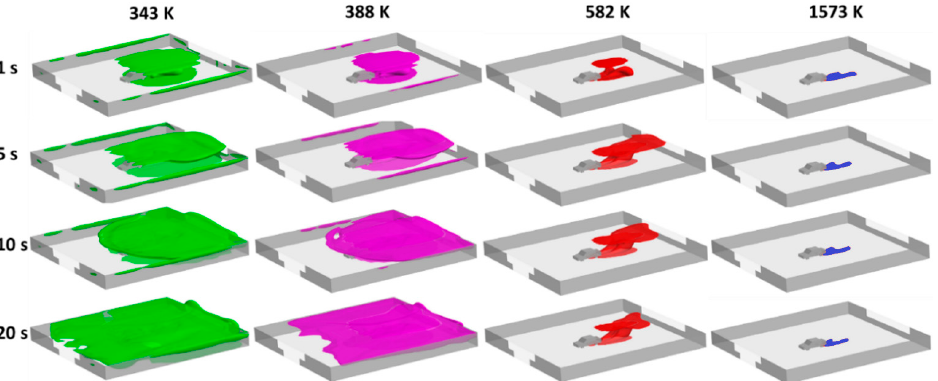
Figure 16. Iso-surfaces showing no-harm (343 K), pain (388 K), fatality (582 K) limits and visible flame temperature (1573 K) for ignited hydrogen release in case 6 (TPRD = 2 mm, 45° angle downward release with tank blowdown and car body).